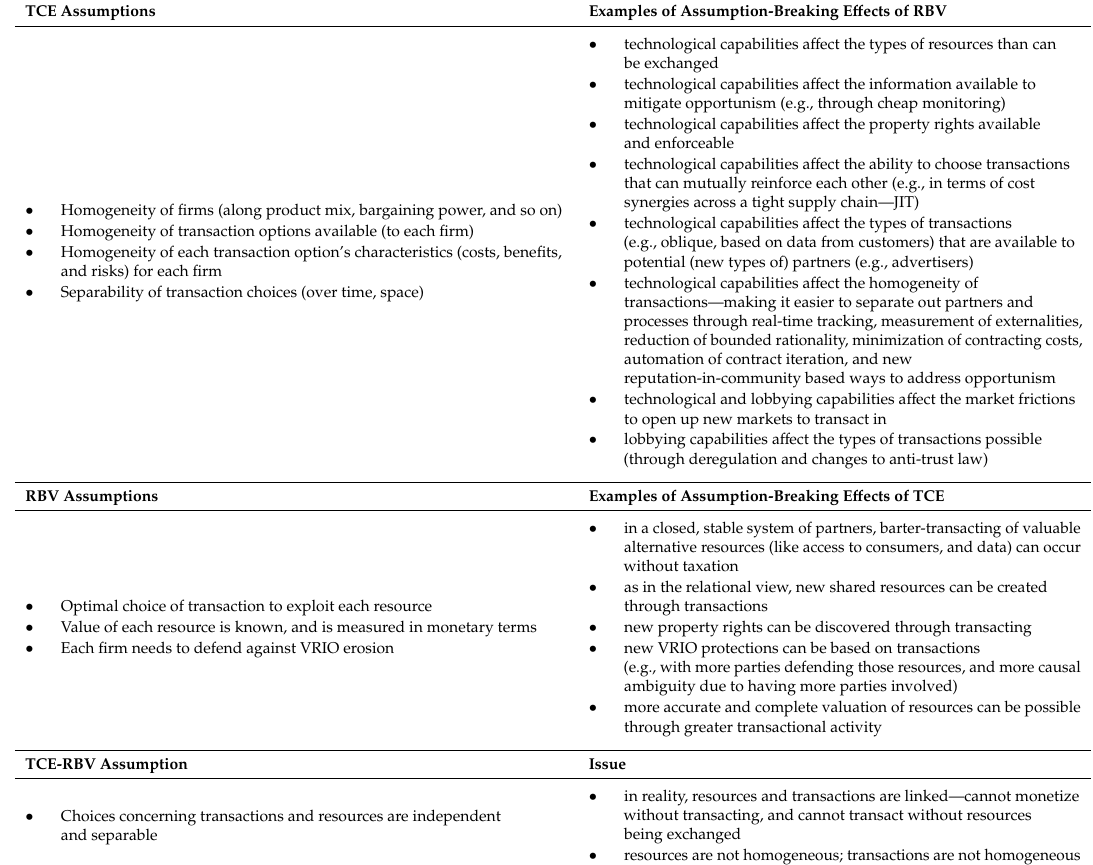
Table 3. TCE-RBV interactions for systems and assumption